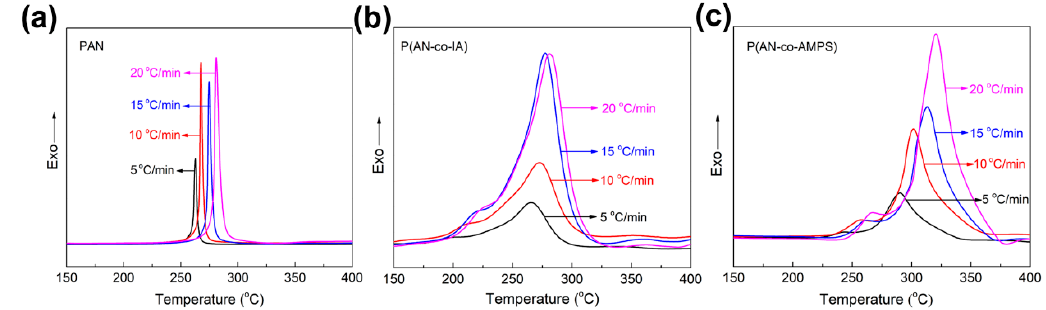
Figure 4. DSC curves of ( a ) PAN, ( b ) P(AN-co-IA), and ( c ) P(AN-co-AMPS) nanofibers heated at different rates under N 2 atmosphere.